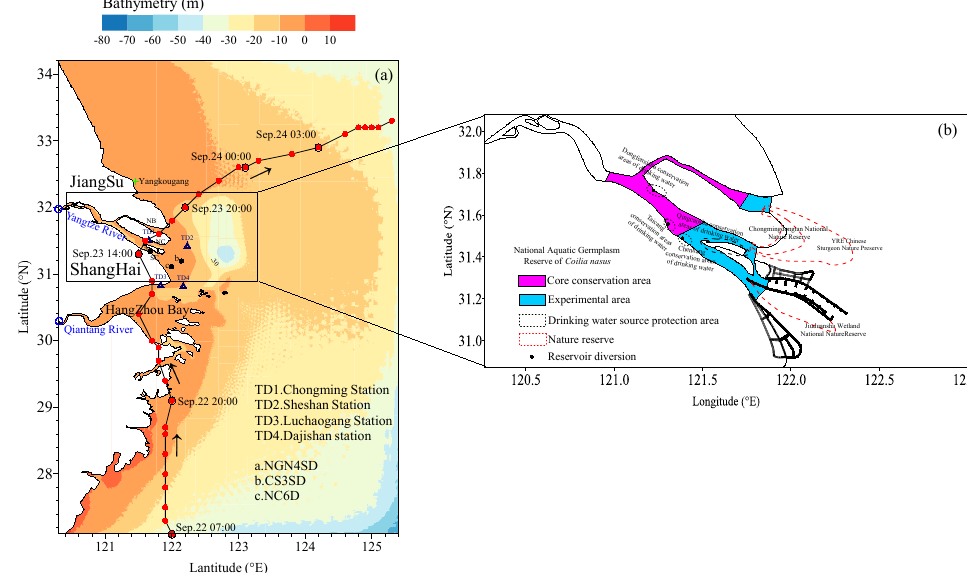
Figure 1. ( a ) Study area (the red circles represent the typhoon track center; the black arrows guide the typhoon’s move direction; the black circles, blue triangles, and green cross indicate the field stations of current, water level, and wave); ( b ) the major environmental area of the YRE vulnerable of oil spills.